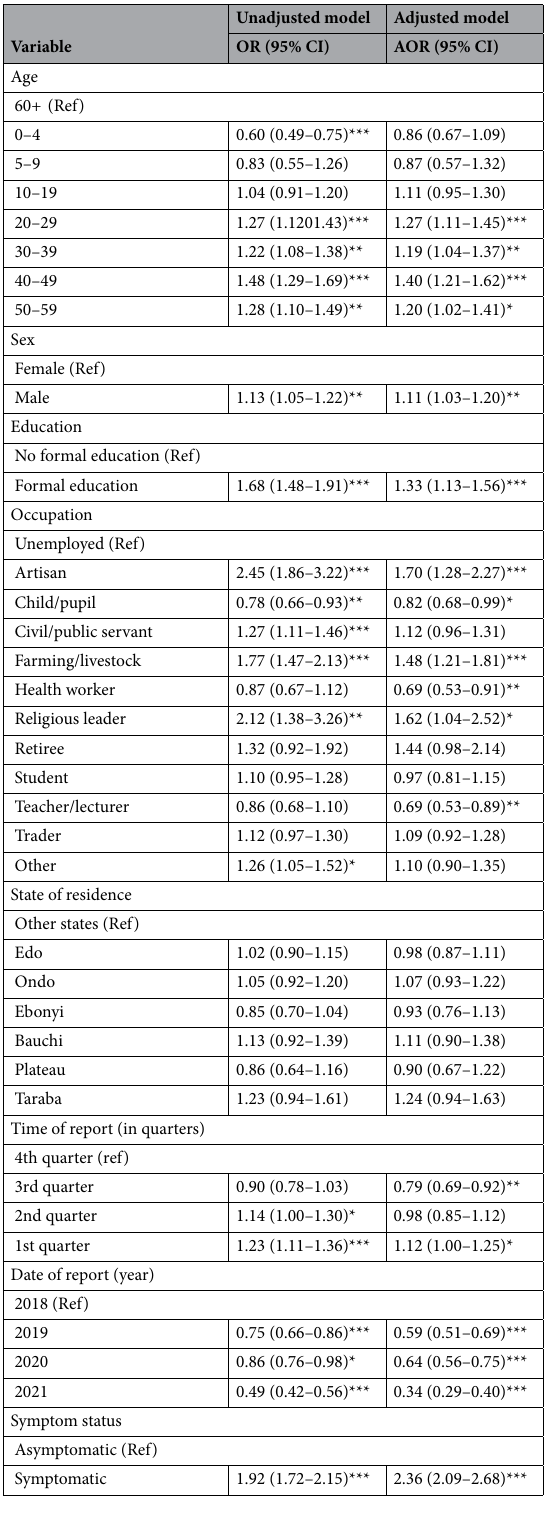
Table 2. Logistic regression models of the socio-demographic predictors of Lassa fever positivity in Nigeria. ***p < 0.001; **p < 0.01; *p <